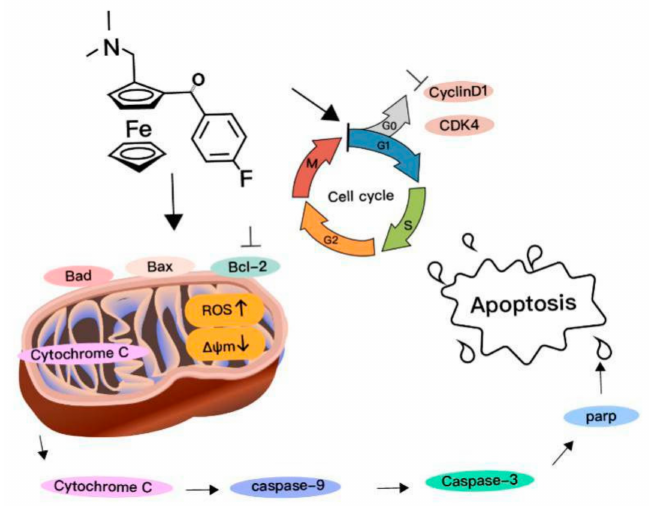
Figure 6. A proposed mitochondrial pathway for apoptosis in HCC cells induced by compound 1